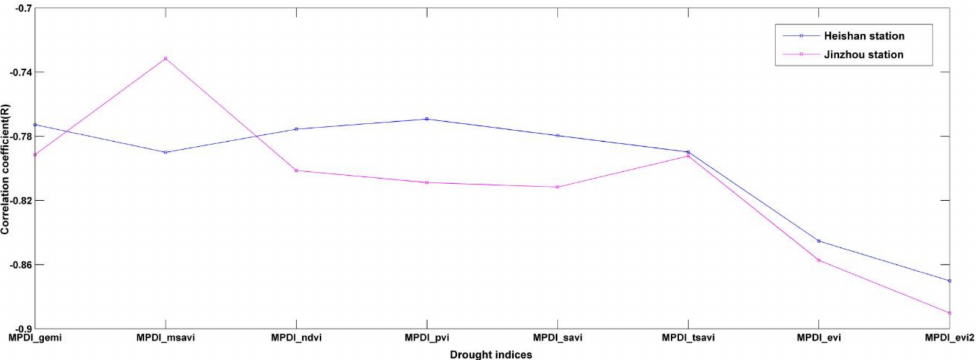
Figure 4. Correlation coefficients between different drought indices with RSMCs measured at the Jinzhou and Heishan meteorological stations.